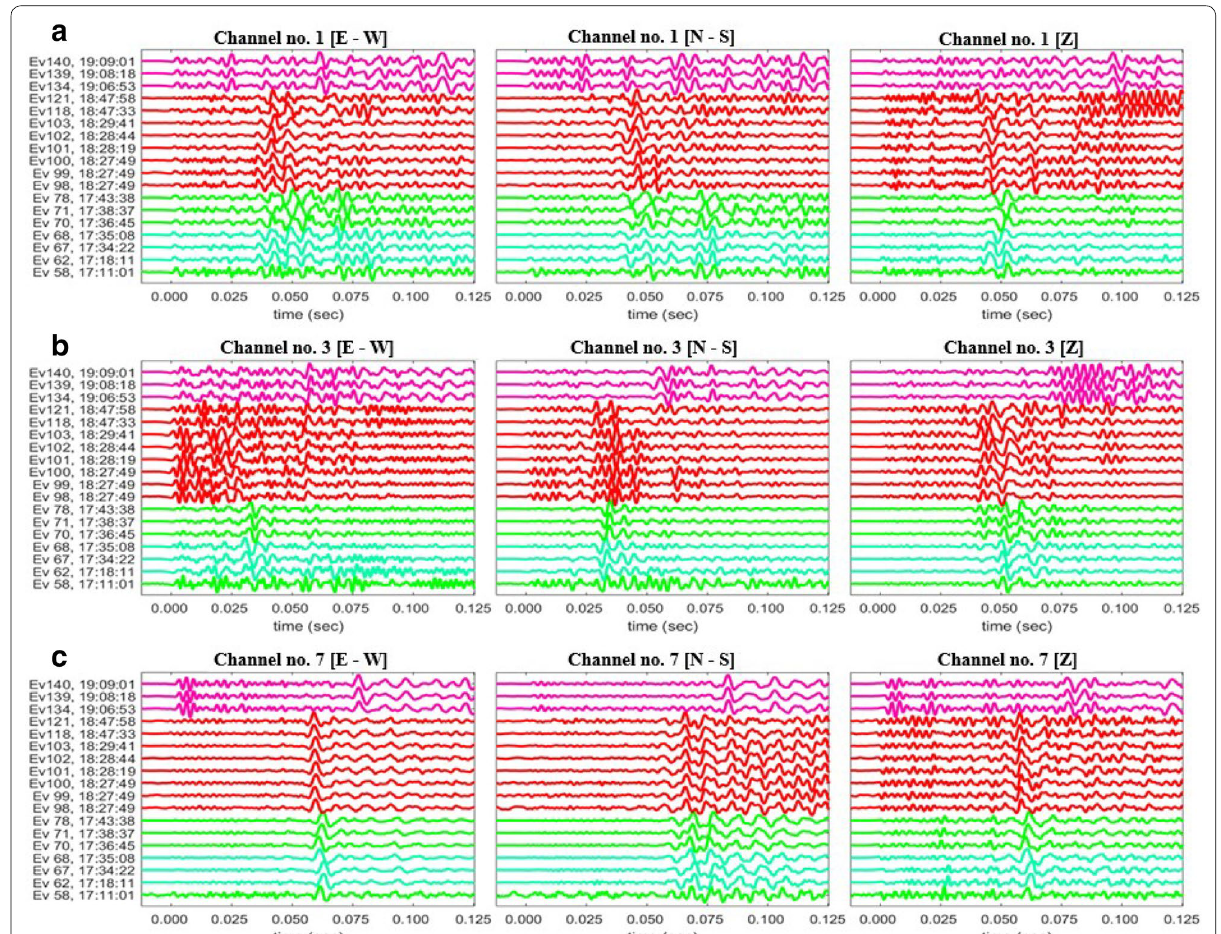
Fig. 7 Waveforms of microseismic events in areas B and C, from three components (3 of 8 channels are shown) colored based on multiplet groups: B1, B2, B3,